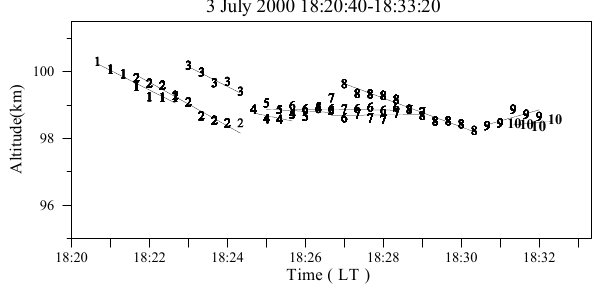
Fig. 5 Fig. 5. Averaged altitude variations of ten striations during their existence in the radar volume on 3 July 2000.